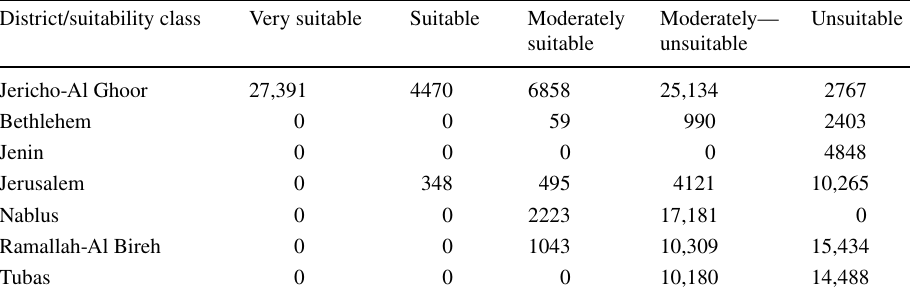
Table 8 One-time costs and their lifetime for date palm cultivation Costs Planting